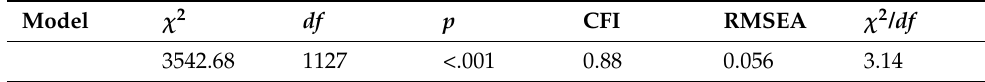
Table 4. Model fit indices for Rasch measurement model.